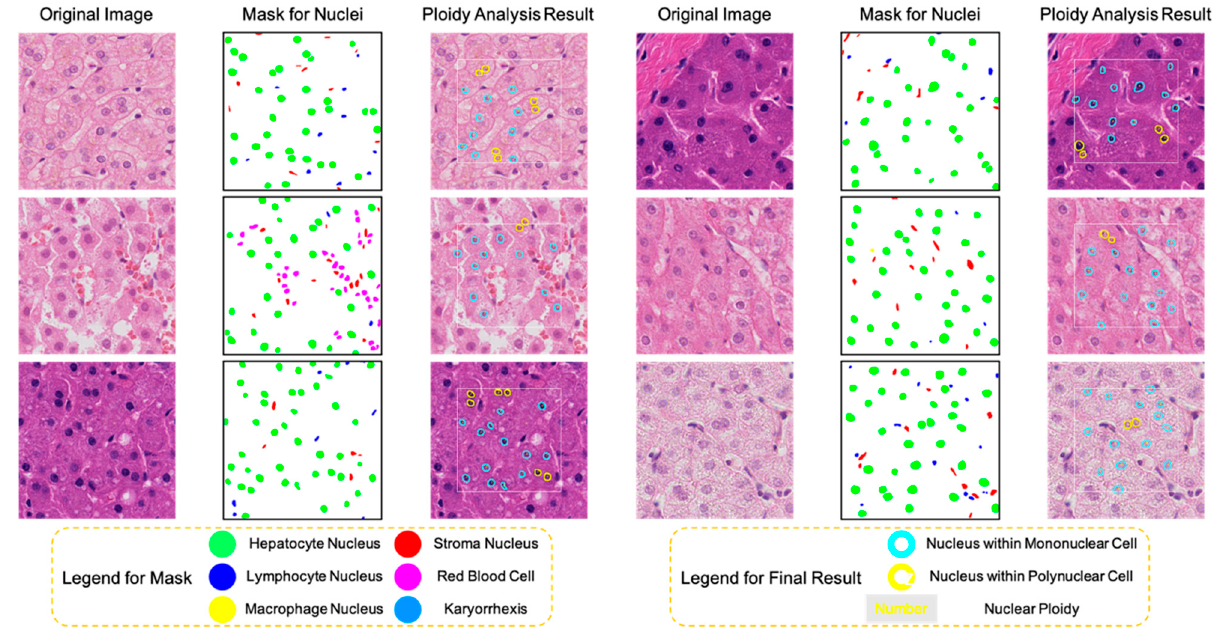
Figure 5. Deep-learning-based hepatic ploidy analysis of human H&E images.